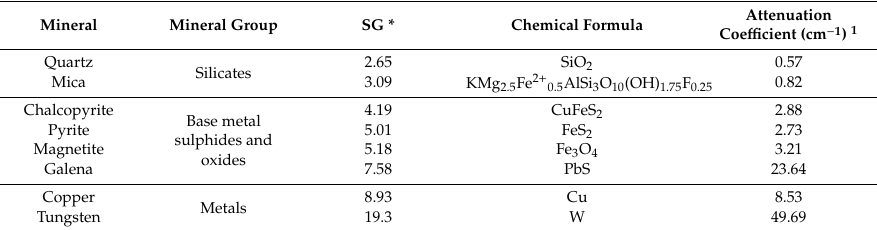
Table 1. Simplified list of the minerals / metals of interest for comparison with the X-ray computed tomography data based on relative mineral densities, their ideal chemical formula and their attenuation coe ffi cients